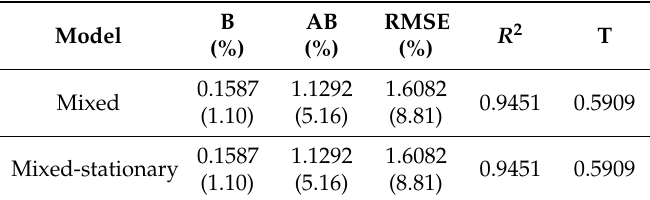
Table 15. Statistical measures and p -values of the Student’s t -test for the stand basal area (m 2 / ha) (Equation (36)).